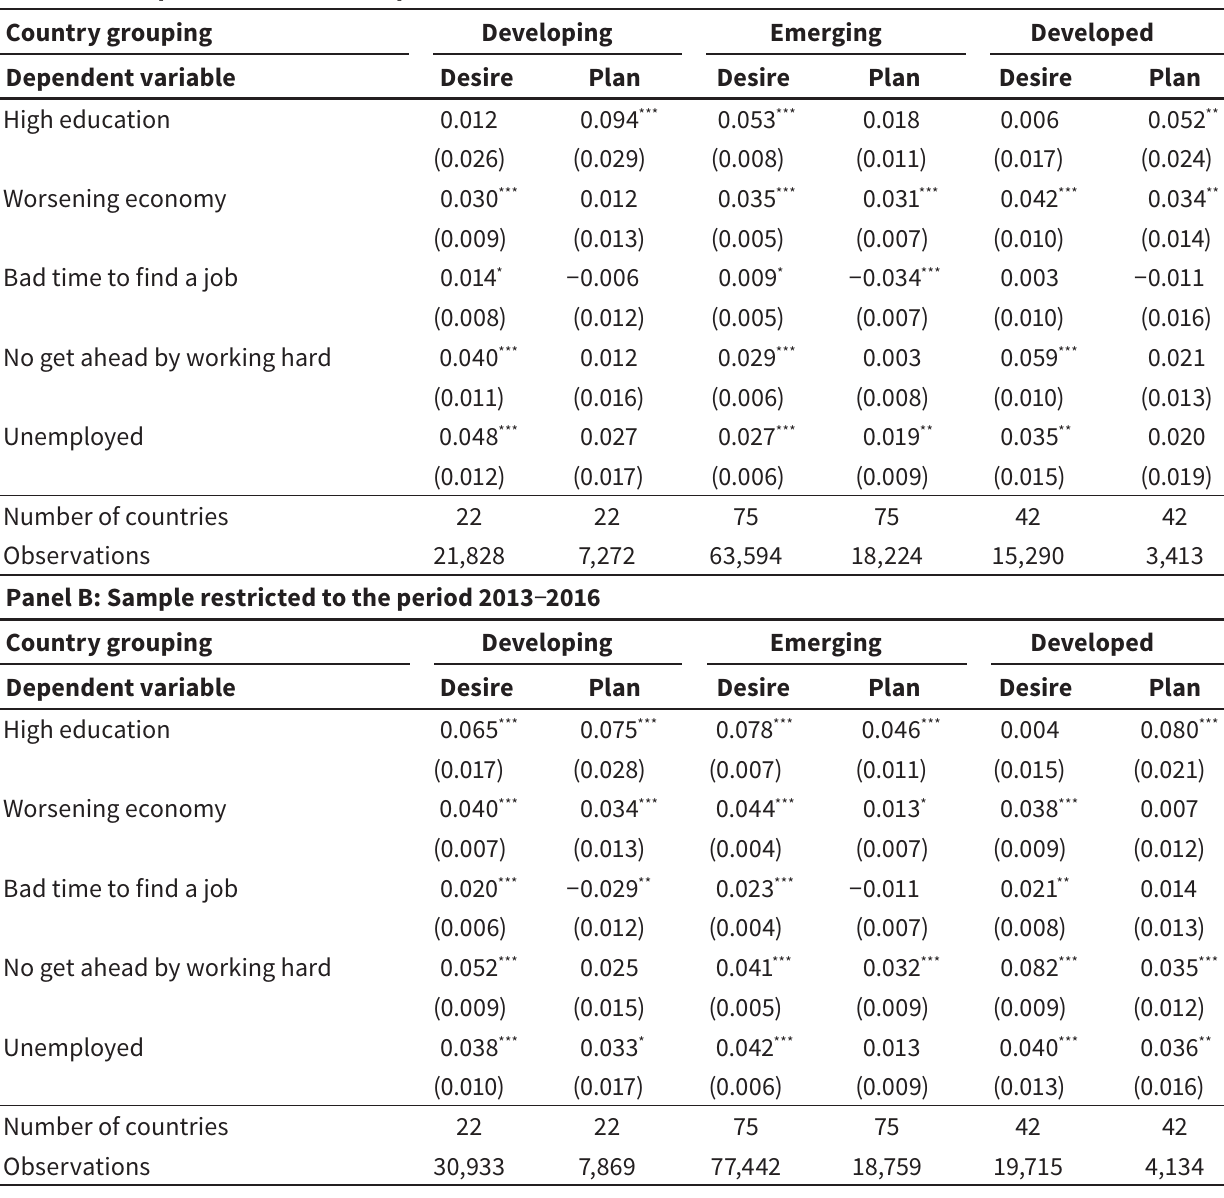
Sensitivity tests across different subsamples, selected results Panel A: Sample restricted to the period 2010–2012